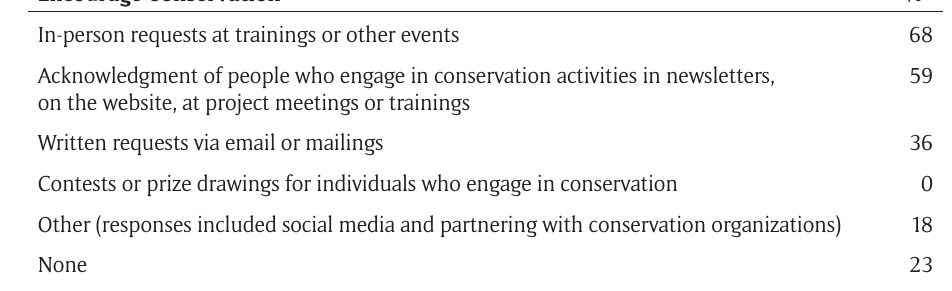
Table 2: Percentage of project leaders using specific strategies to encourage conservation actions among their volunteers, n =